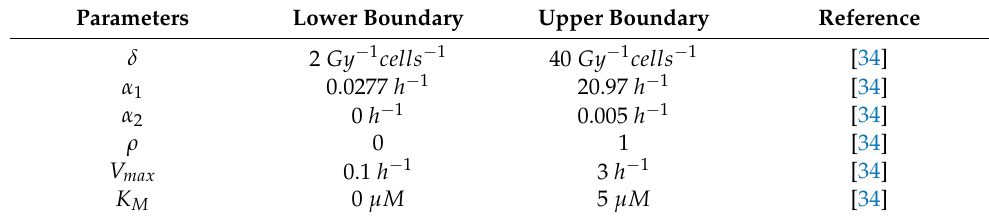
Table 1. The parameter space is restricted to the range of values.